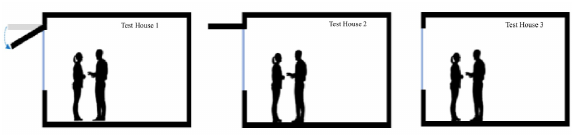
Fig. 4. Field measurement conditions for each test house.